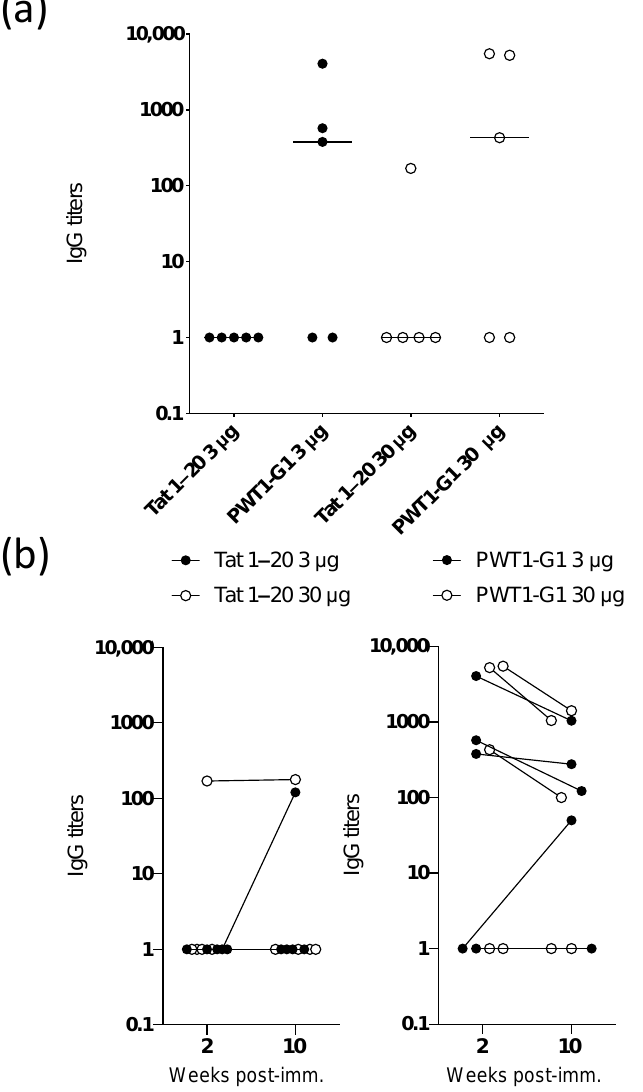
Figure 4. Analysis of IgG responses induced by Tat 1–20 alone or Tat 1–20 conjugated to a PWT scaffold over time. ( a , b ) Mice were immunized SC on three separate occasions with 3 or 30 µ g of Tat 1–20 or PWT1-G1. Serum samples were collected 2 ( a , b ) and 10 weeks ( b ) after the third immunization. IgG titers specific for Tat 1–20 were measured via ELISA. Each dot represents one mouse, and horizontal bars indicate median values. Significance was determined using the two-tailed Mann–Whitney U test with Bonferroni correction for multiple comparisons ( a ) or Fisher’s exact test ( b